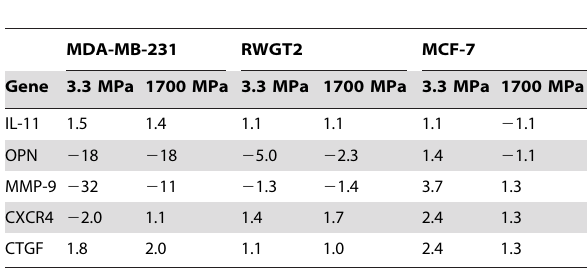
Table 1. Expression of a selected panel of genes associated with osteolytic bone disease as a function of substrate rigidity.